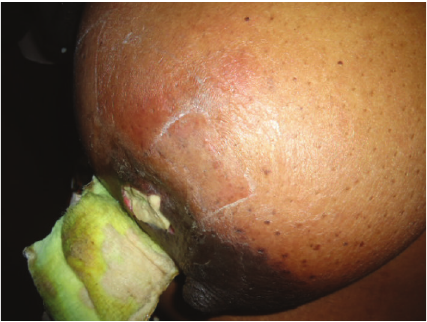
Figure 2: Tuberculous granuloma, HE × 40.